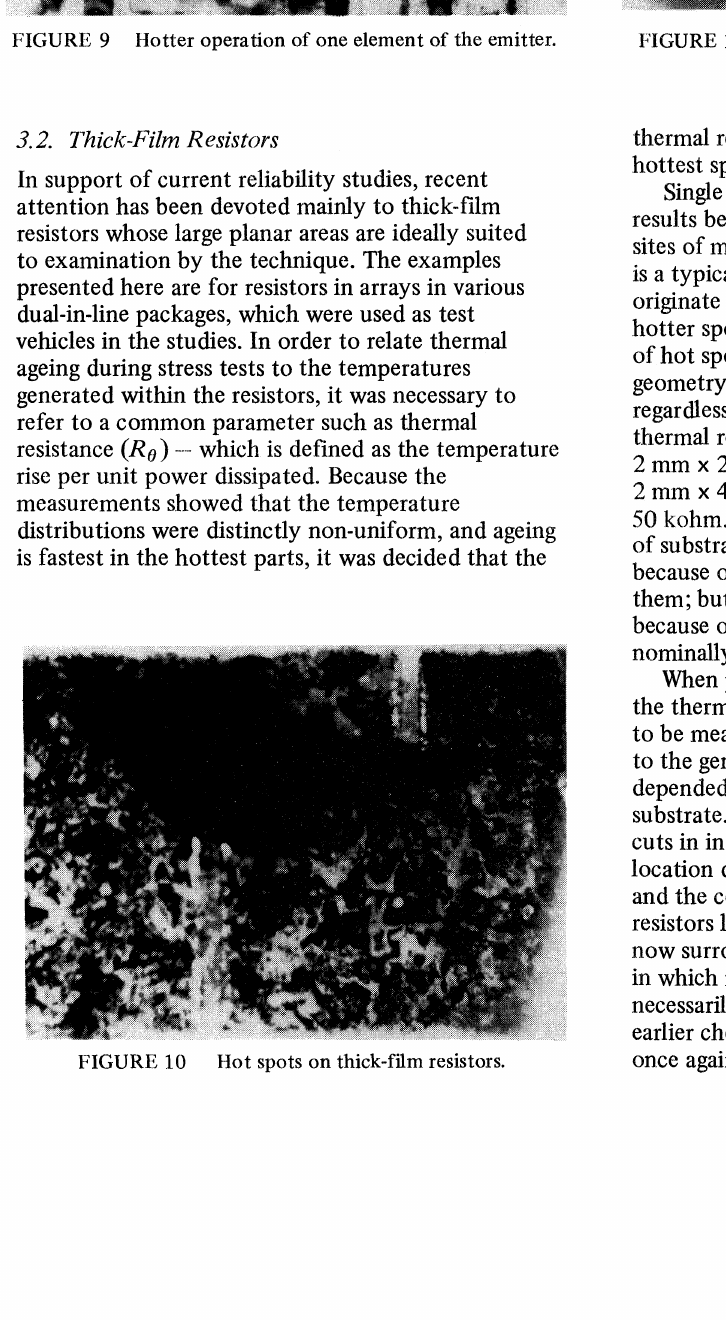
ttotter operation of one element of the emitter. Hot spots on thick-film resistor arrays.